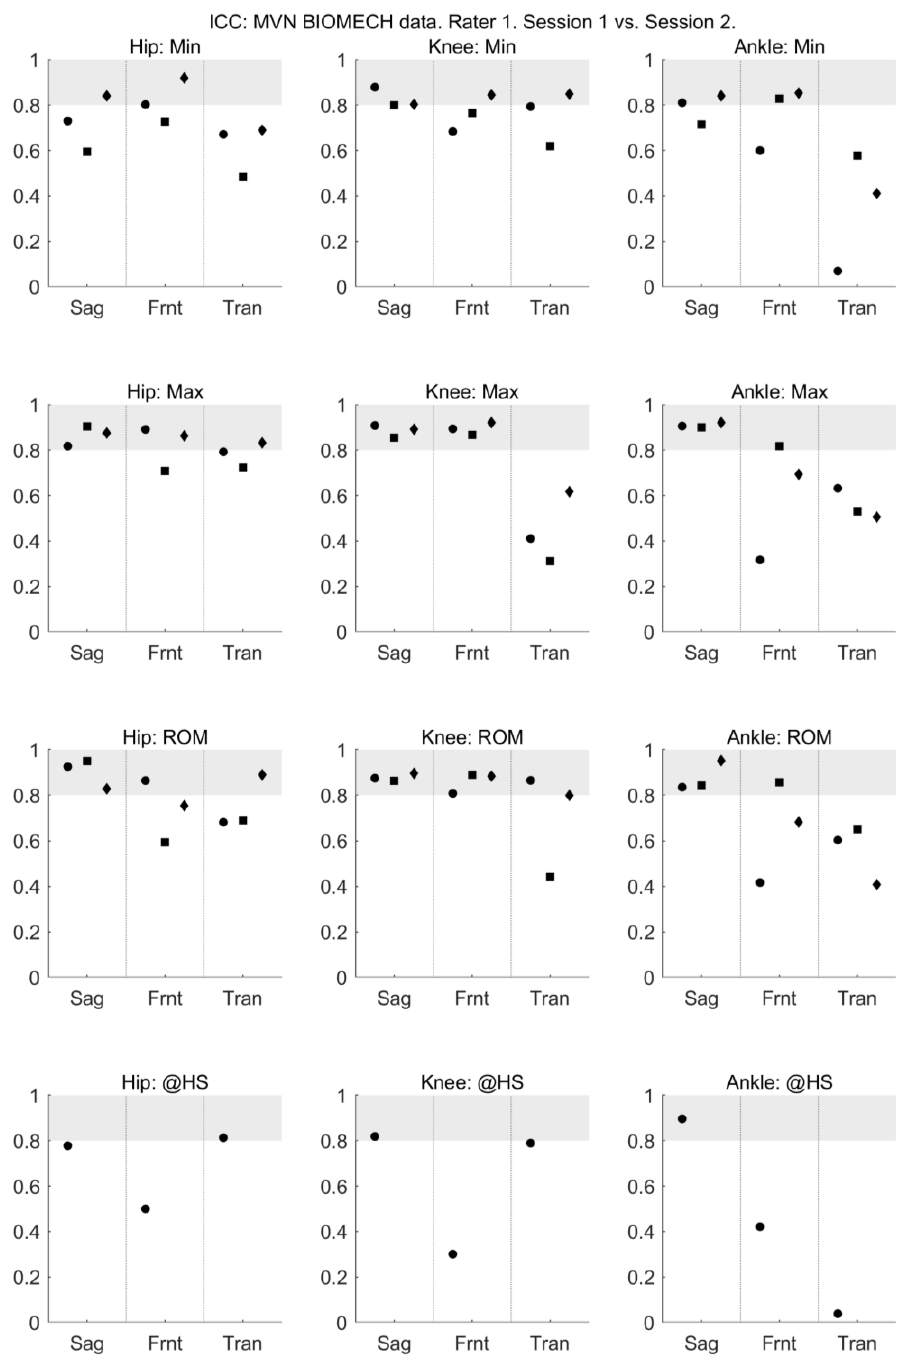
Figure 1. Between-session (within-rater) intraclass correlation coefficient of MVN data collected by rater 1 (musculoskeletal physiotherapist) in sessions 1 and 2. Intraclass correlation coefficient is shown for the minimum angle (min; top row ), maximum angle (max; second row ), range of motion (ROM; third row ) and angle at heel strike (@HS; bottom row ) for the hip (left-most column), knee (centre column) and ankle (right-most column) joints in the sagittal (Sag), frontal (Frnt) and transverse (Tran) planes of movement. The three data points in each plane correspond to the walk (left-most point; circle), squat (centre point; square) and jump (right-most point; diamond) tasks. Grey shading indicates values considered to indicate excellent reliability.